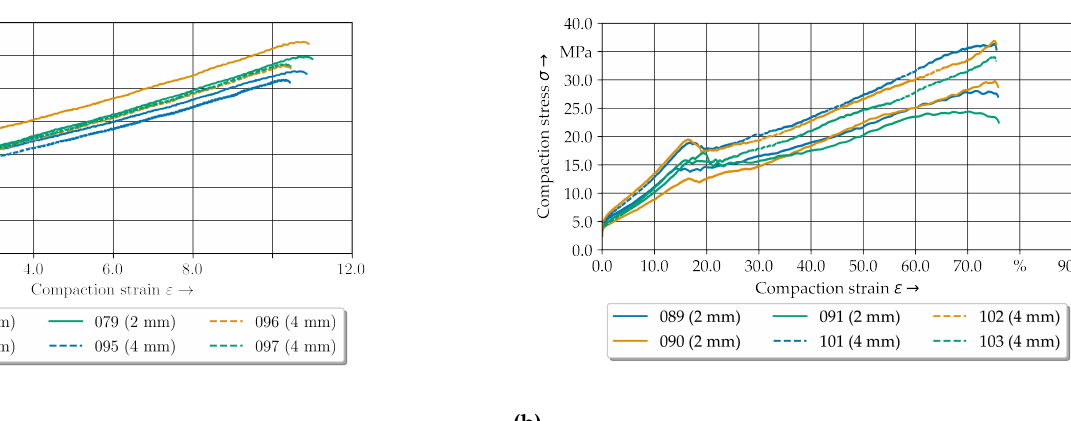
Figure 17. Compaction curves at 200°C with the two tested configurations. ( a ) 10% compaction level. ( b ) 75% compaction